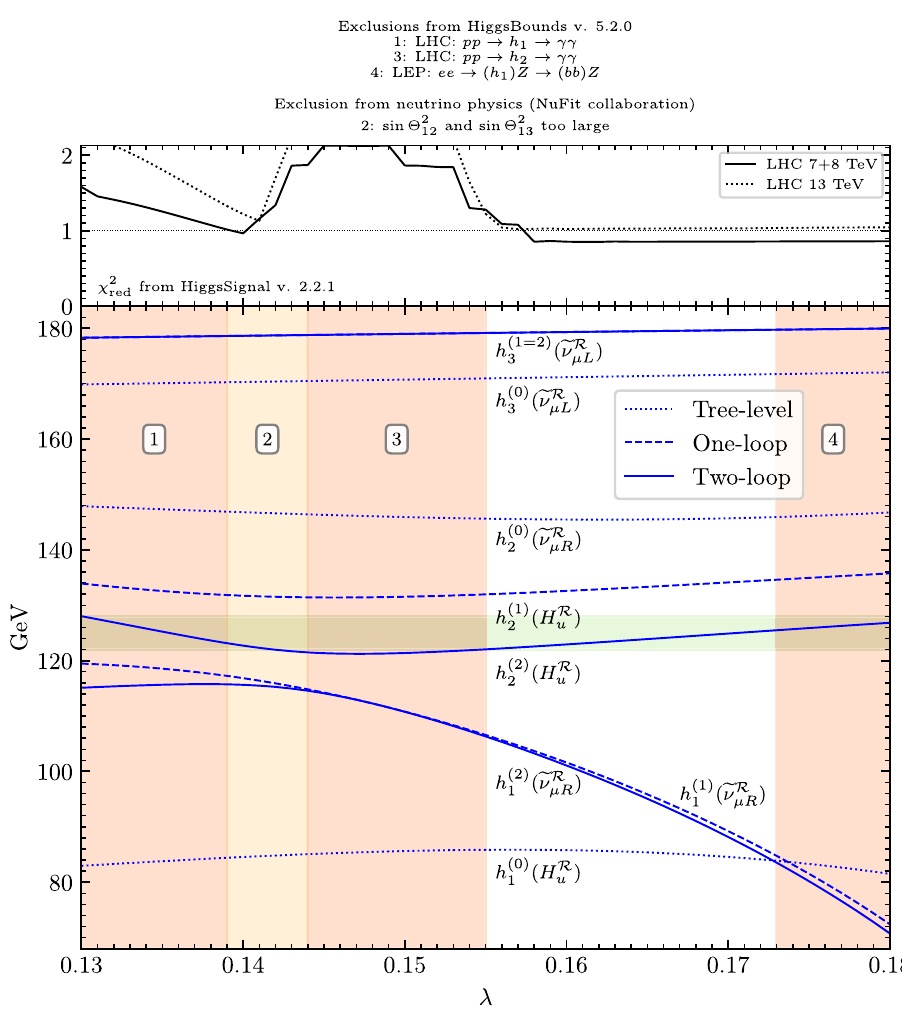
Fig. 4 CP -even scalar spectrum in the scan over λ at tree level, one-loop level and partial two-loop level. We show in the brackets the dominant composition of the tree-level, one-loop and two-loop mass eigenstates h ( 0 ) , h ( 1 ) and h ( 2 ) , in the experimentally allowed region of the plot. The desired SM-like Higgs-boson mass is indicated with the horizontal green band, assuming a theory uncertainty of 3 GeV. The red regions are excluded by direct searches for additional scalars. In the yellow region the prediction for the mixing angles of the neutrinos lies outside of the 3 σ band of the experimental measurement. On top we show χ